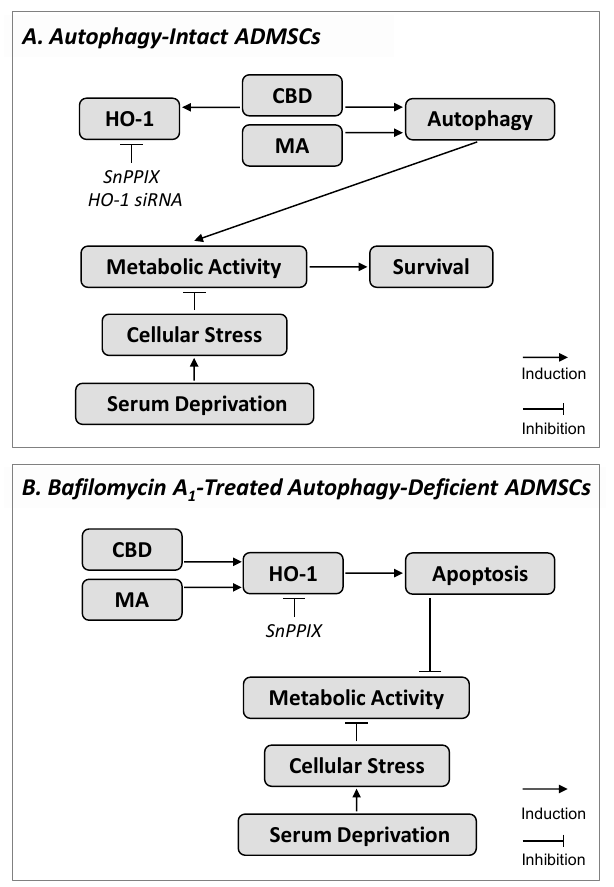
Figure 9. Proposed mechanism and functional consequence underlying cannabidiol (CBD)- and R(+)-methanandamide (MA)-induced HO-1 expression in ADMSCs. In cells cultured under serum deprivation ( A ) and thus exposed to time-dependent decreasing metabolic activity, CBD and MA promoted autophagy, which led to increased metabolic activity that could promote cell survival. In addition, the CBD caused an upregulation of HO-1, which, however, was not involved in increasing metabolic activity and autophagy. The involvement of different cannabinoid-binding receptors in cannabinoid effects on metabolic activity and HO-1 expression was excluded. On the other hand, inhibition of autophagy by bafilomycin A 1 ( B ) led to apoptosis induction and inhibition of the increased metabolic activity caused by cannabinoids. Under these conditions, MA also triggered a profound HO-1 expression. Additional HO-1 inhibition finally led to a significant reversal of the bafilomycin A 1 /cannabinoid-induced apoptosis. In summary, CBD and MA protected ADMSCs under conditions of serum deprivation via HO-1-independent induction of autophagy ( A ), whereas cannabinoid-induced HO-1 contributed to apoptosis under conditions of additional autophagy inhibition ( B ). The sequence shown with inductive and inhibitory arrows connecting the boxes corresponds to the effect of CBD or MA in the absence of HO-1 inhibition. The HO-1-inhibiting strategies (SnPPIX, HO-1 siRNA) are shown in italics, whereby their target, but not their consecutive effect, is shown.